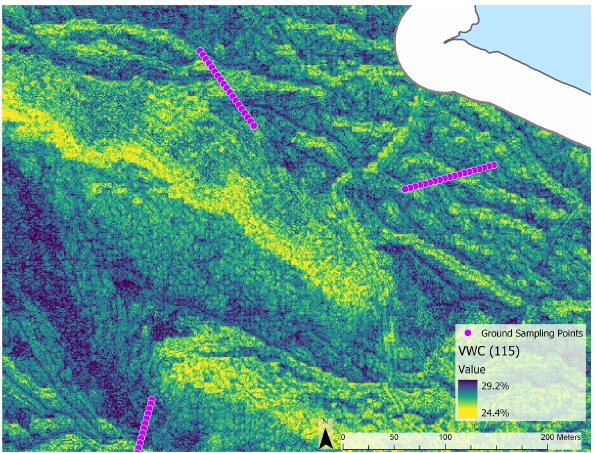
Figure 11. Magnified map of predicted soil moisture content (per- cent) map for water year day 115 (23 January